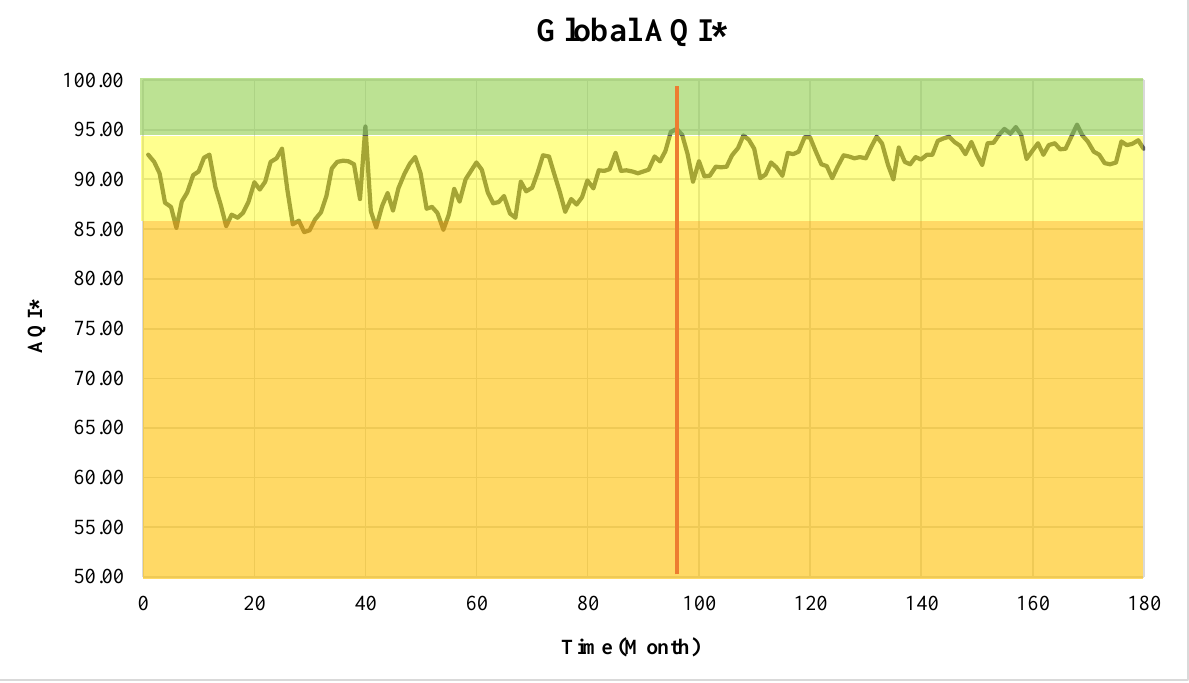
Figure 7. Global AQI* function. Data series: Barcelona 2001-2015. Red line stands for January’09.